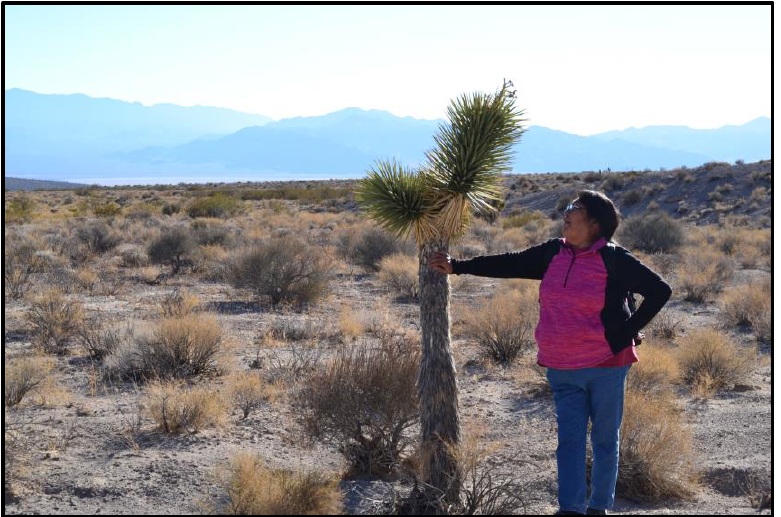
Figure 19. Joshua Tree and Writers Committee Member (Source Stoffle).